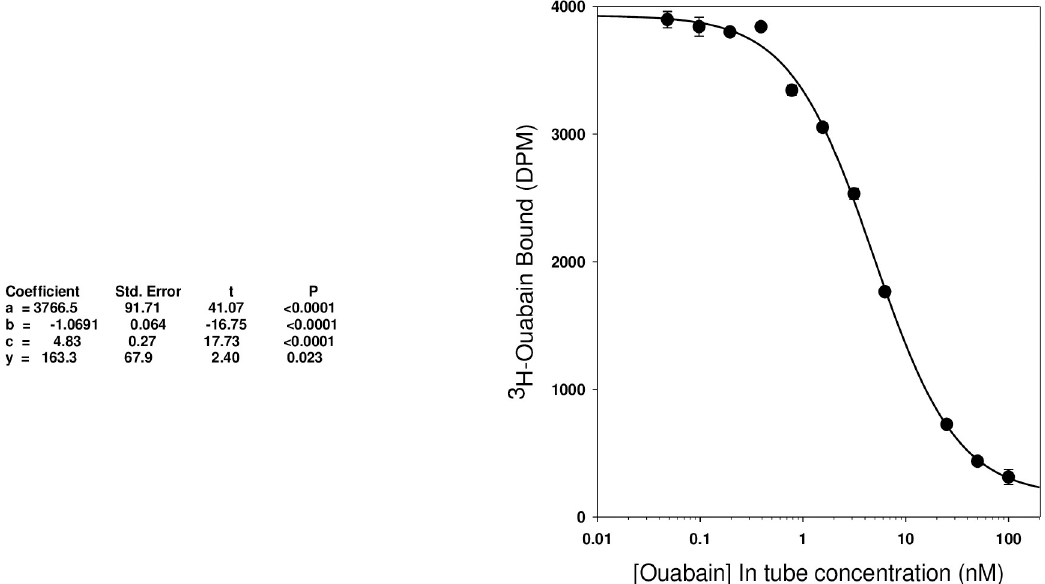
Fig 2. ouabain standard curve. Radioimmunoassay standard curve for ouabain. Each point is the mean ± SEM for triplicate determinations. Error bars are obscured where the symbol diameter > sem. The data were fitted iteratively to the equation described in the text and the resultant parameters including coefficients (a = B max , b = slope, c = EC 50 , d = nonspecific binding), standard errors, t statistics, and probability values for the fit are shown below the figure.